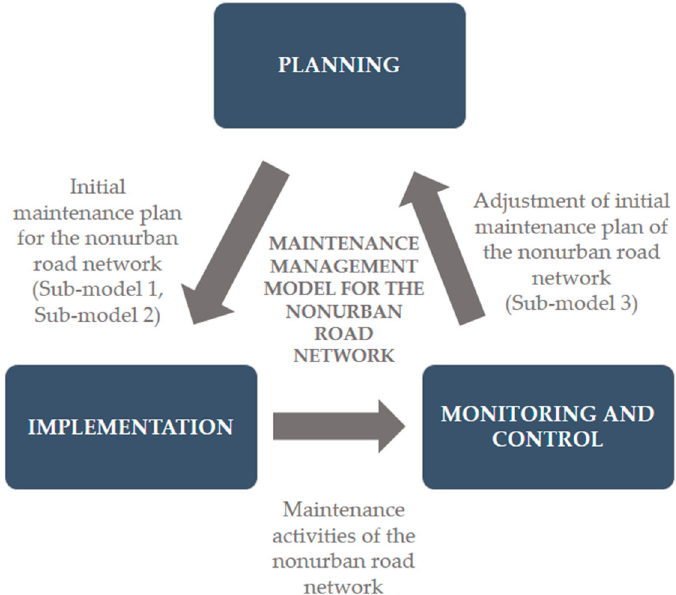
Figure 1. Maintenance management model for nonurban road network.